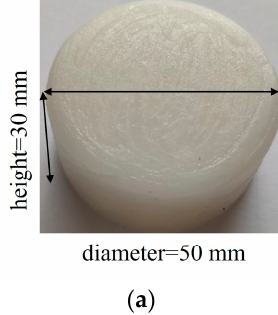
Figure 1. The raw materials of SSPCM: ( a ) solid–liquid mixed paraffin, ( b ) HDPE particle, ( c ) ex- panded graphite powder. ( c ) expanded graphite